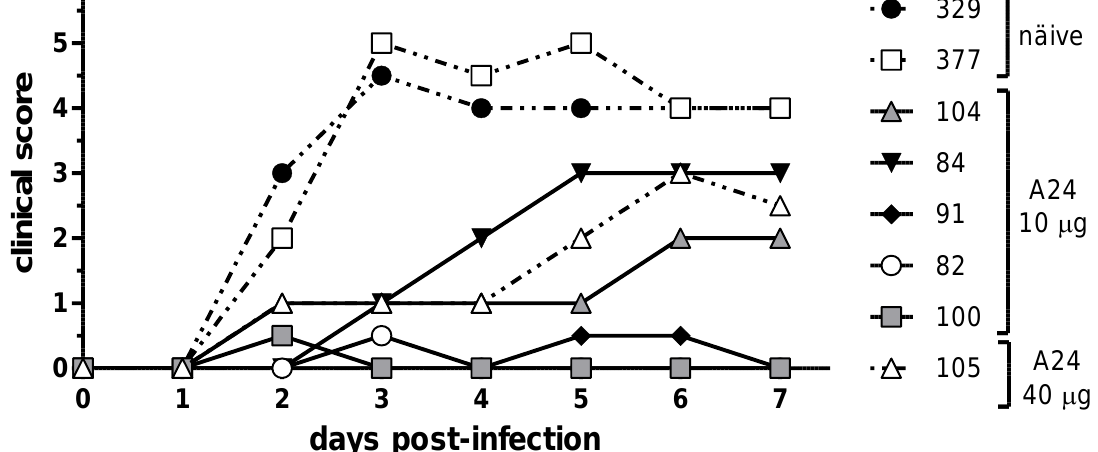
Figure 1. Progression of foot-and-mouth disease (FMD) clinical signs after heterologous challenge. Each line depicts the clinical scores registered for individual animals after infection with FMD virus (FMDV) A/Arg/01. The score was determined by assigning 1 point for hyperthermia > 40.0 °C and 1 point for each limb with vesicular lesions, reaching a maximum daily score of 5 points. Mild hyperthermia (≥ 39.5 °C and ≤ 40.0 °C) in the absence of other FMD-related signs was scored as 0.5 points.